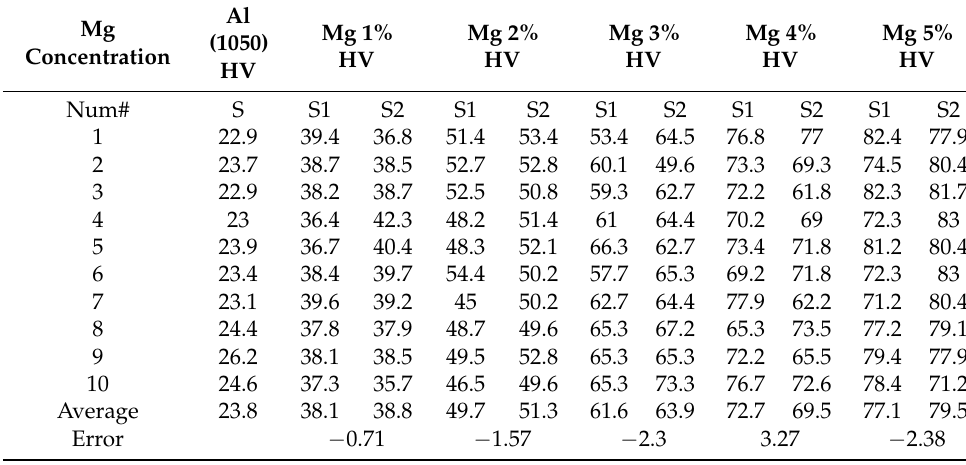
Table 4. Hardness test results for Al (1050) alloy with different Mg percentiles.